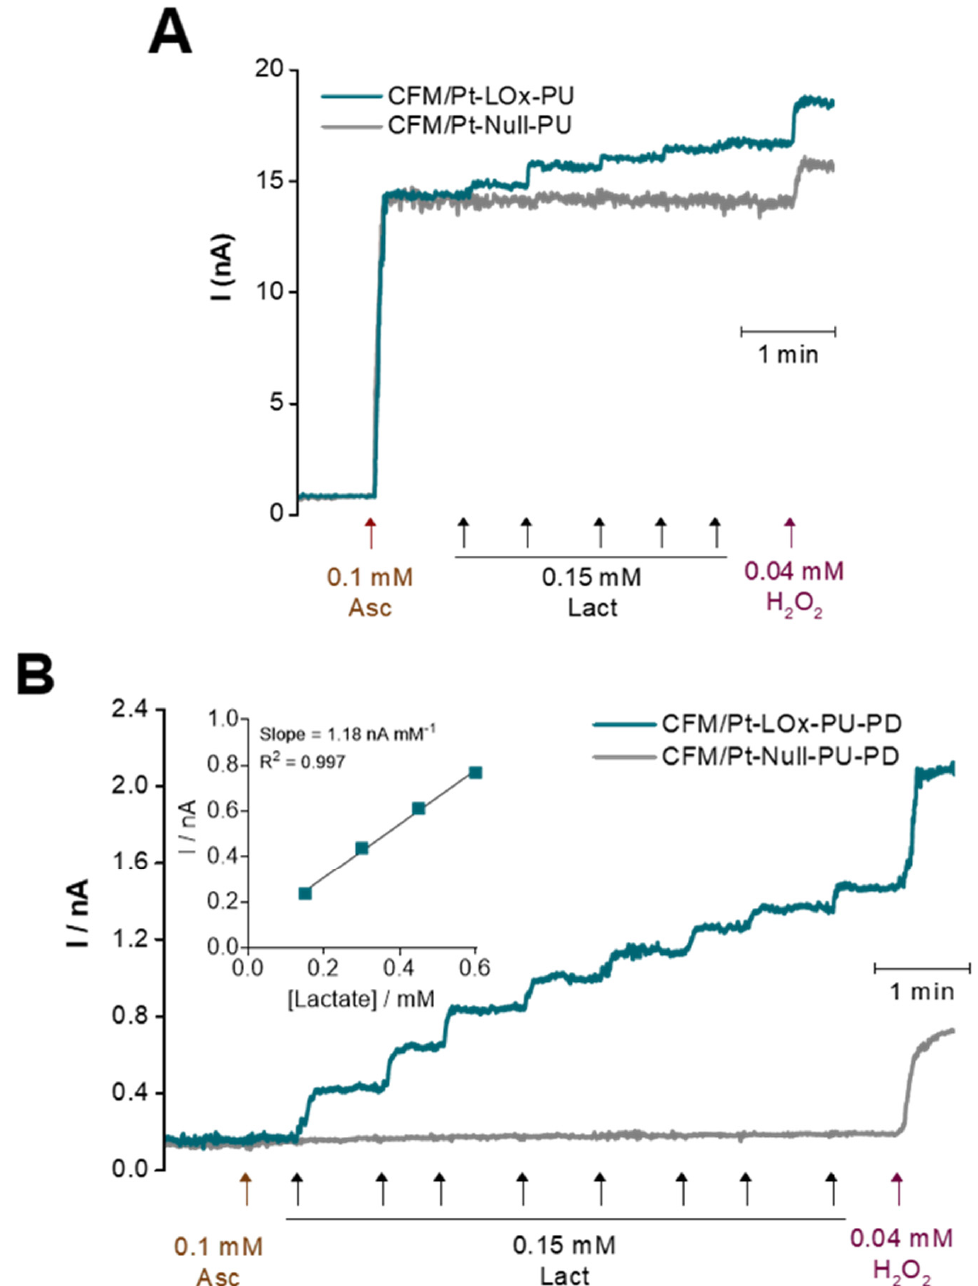
Figure 4. Representative calibration curves of CFM/Pt-based lactate microbiosensors before ( A ) and after ( B ) addition of the PD permselective membrane. Lactate (blue) and null (grey) microbiosensors were calibrated by consecutive additions of lactate in the presence of ascorbate followed by the addition of H 2 O 2 to evaluate response to the reporter molecule. Additions and their final concentrations are indicated by arrows. Inset in B: Linear regression of the calibration curve up to 0.6 mM.